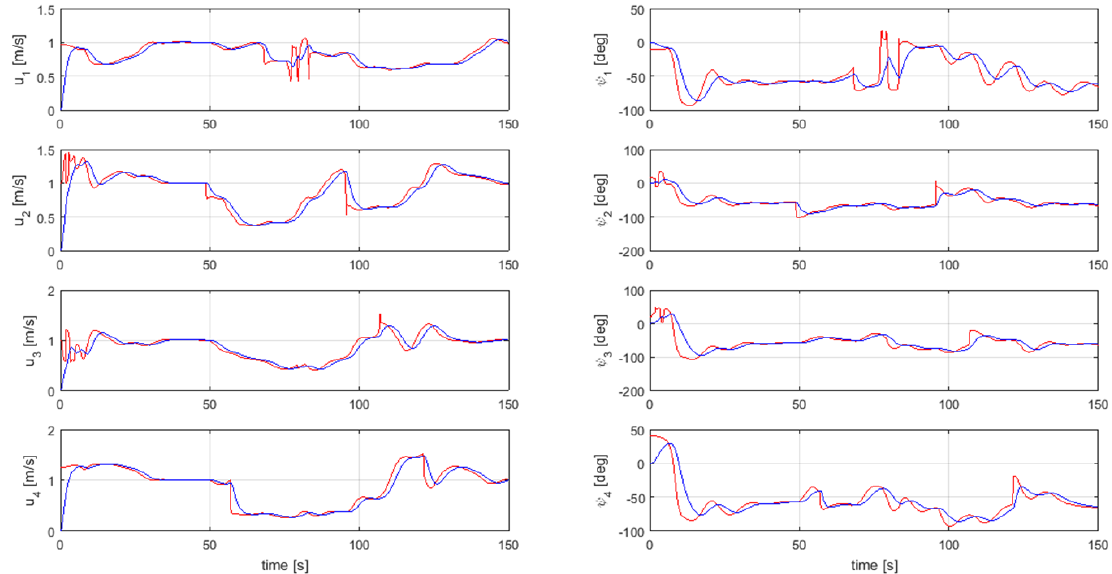
Figure 17. USV speed and heading profiles during swarm aggregation combined with path-following guidance for four